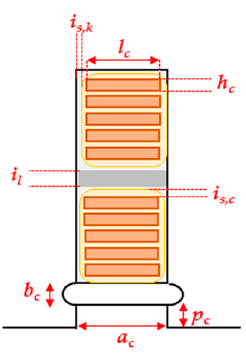
Figure 2. Slot edge and parameters adopted for the slot dimensions.